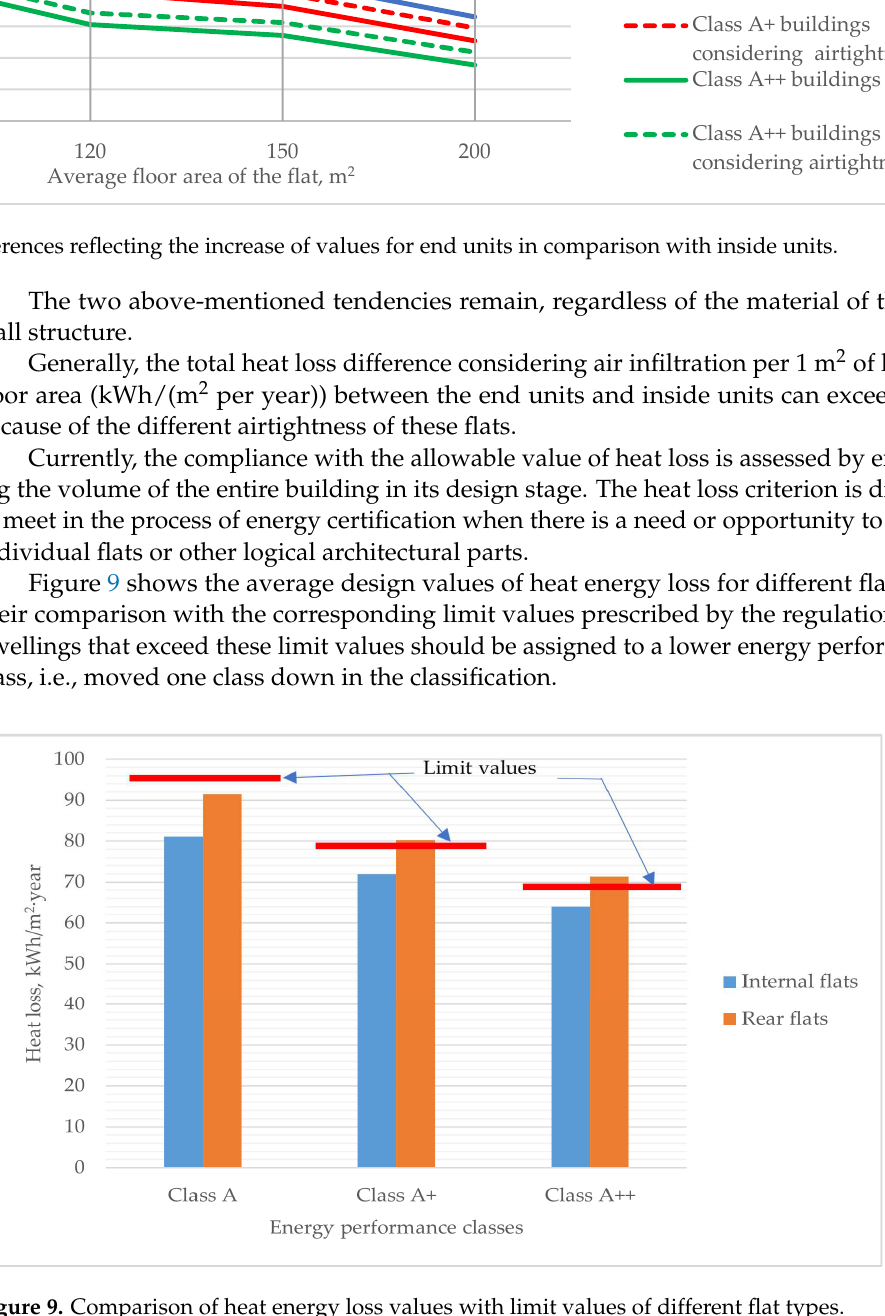
Figure 9. Comparison of heat energy loss values with limit values of different flat types.